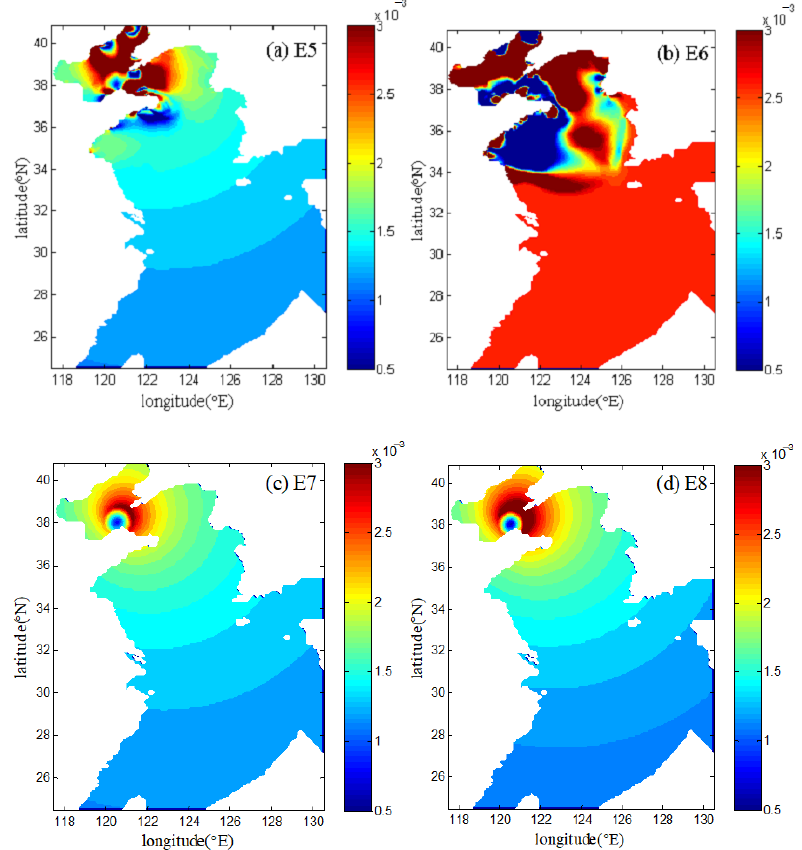
Figure 6. Spatial distributions of the calculated drag coefficients in E5 − E8 ( a – d ) at 20:00 p.m. on 26 July 1972 during Typhoon 7203.